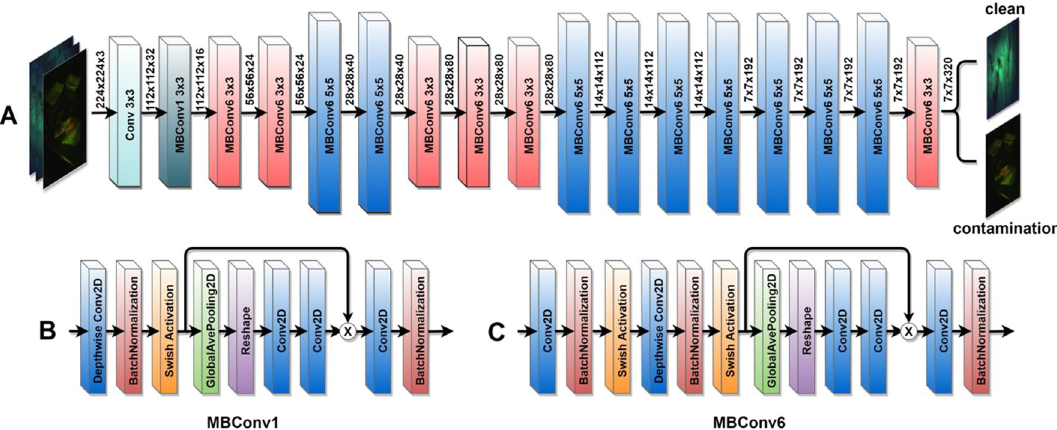
Figure 4. ( A ) A concise representation of the EfficientNet-B0 model. ( B ) The building blocks of MBConv1. ( C ) The building blocks of